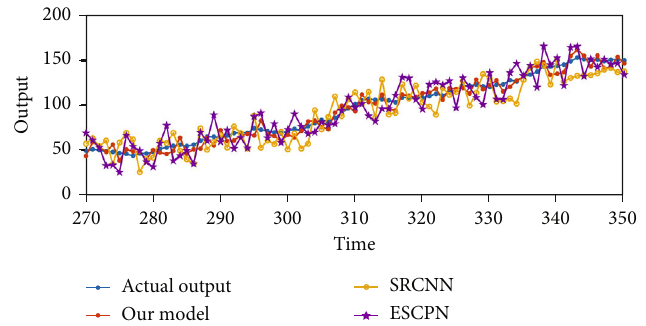
Figure 4: The feature degree of mural recognition by di ff erent algorithms.